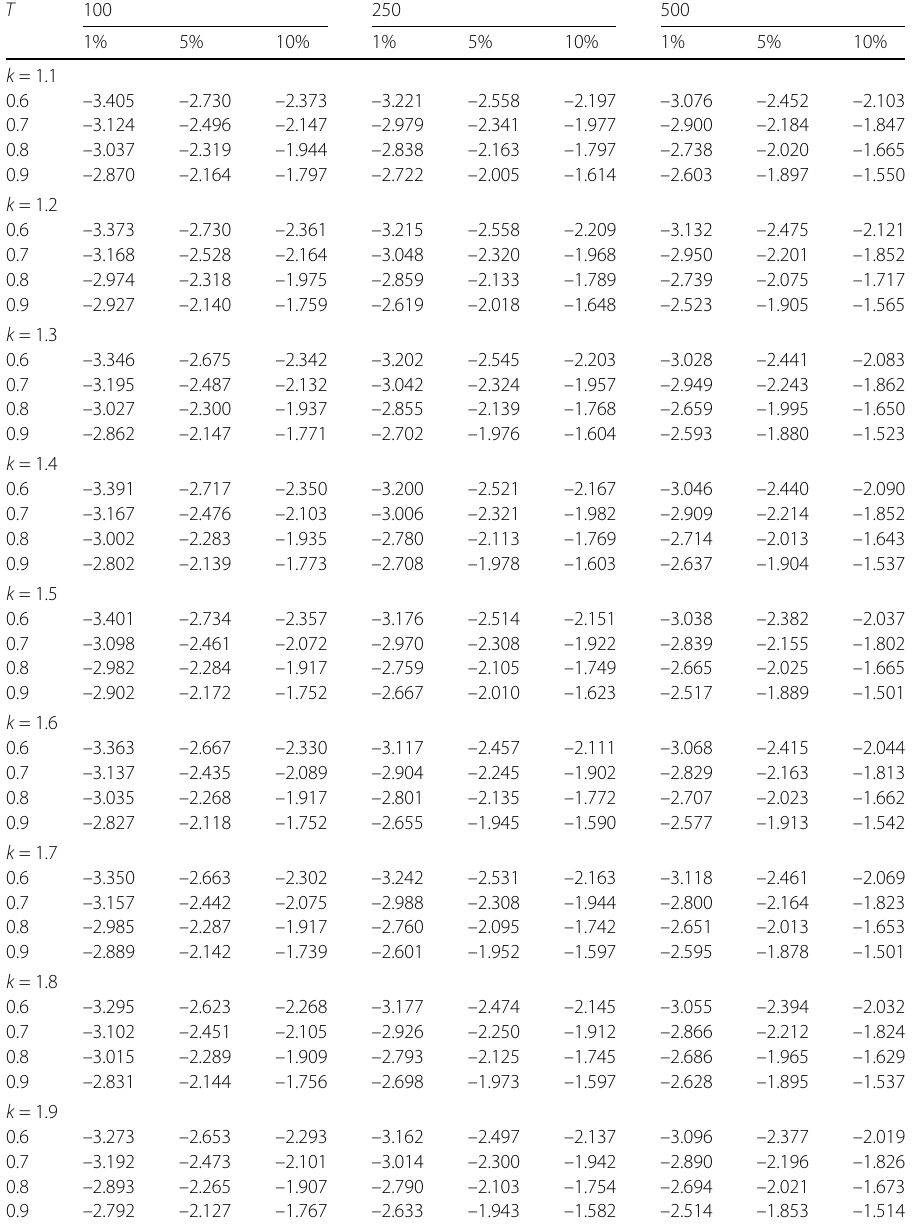
Table B4 Critical values for FI models intercept and trend included in fractional frequency Fourier function d =